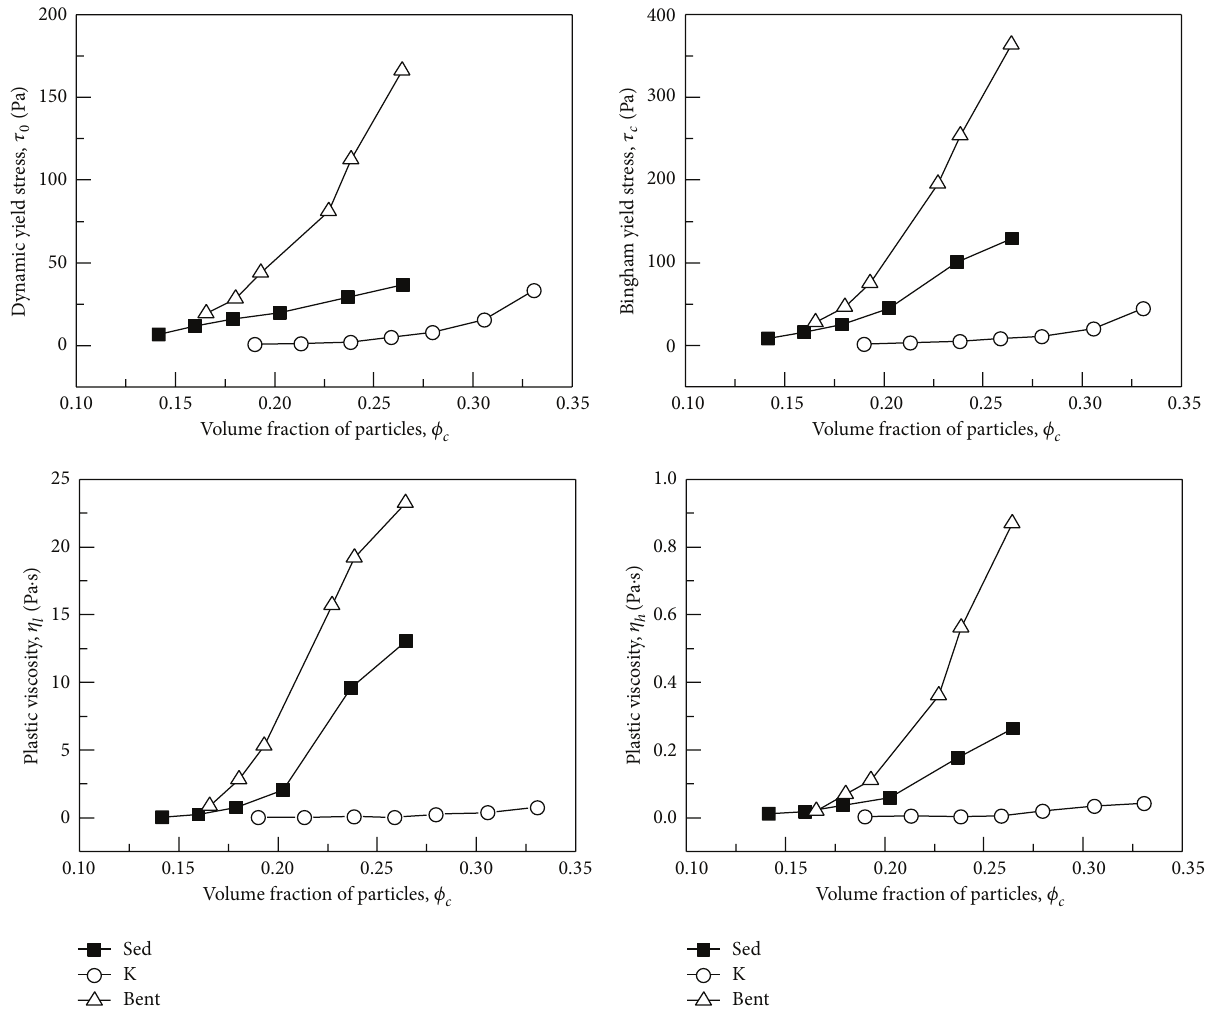
Figure 7: Bilinear rheological parameters for Group Sed, Group K, and Group